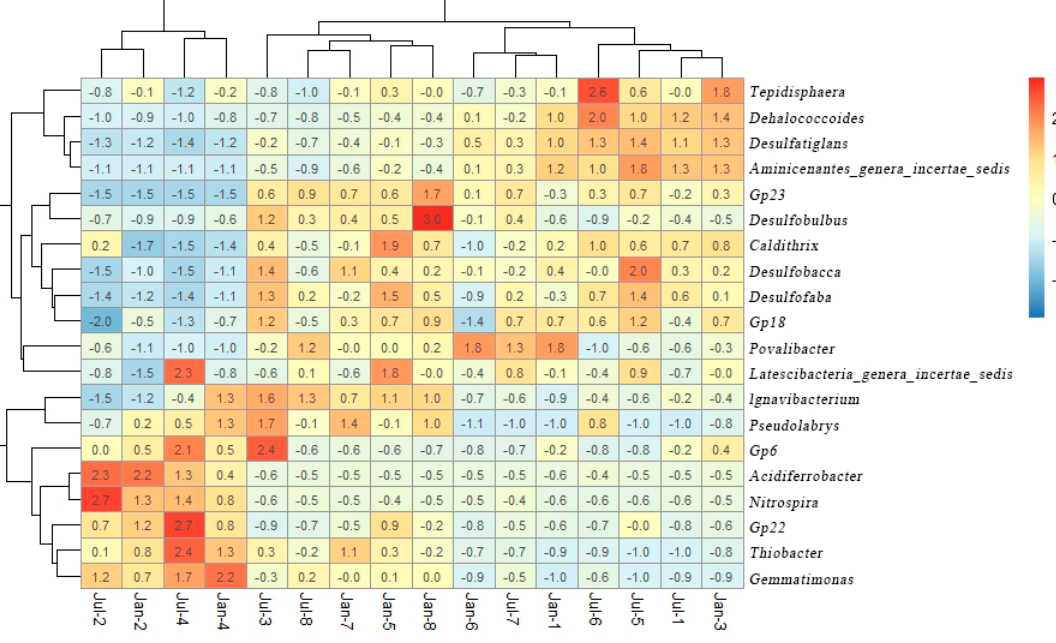
Figure 4. Heatmap of the distribution of the 20 most abundant bacterial genera present in the soil samples. The relative abundance of bacterial genera was indicated by color intensity.